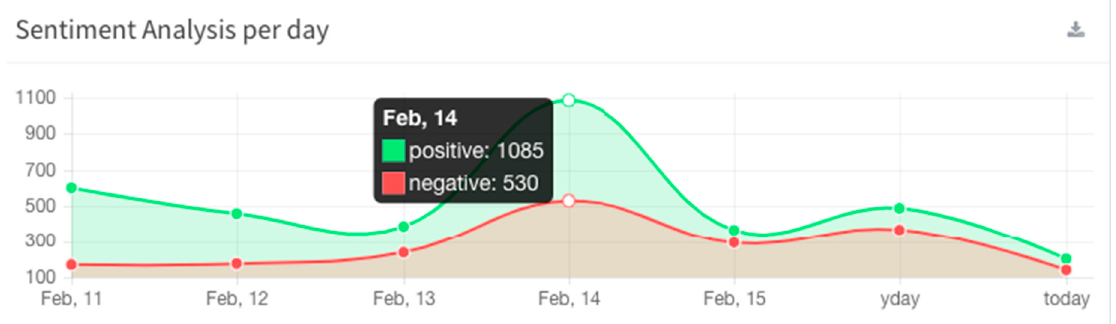
Figure 1. Sentiment analysis per day.